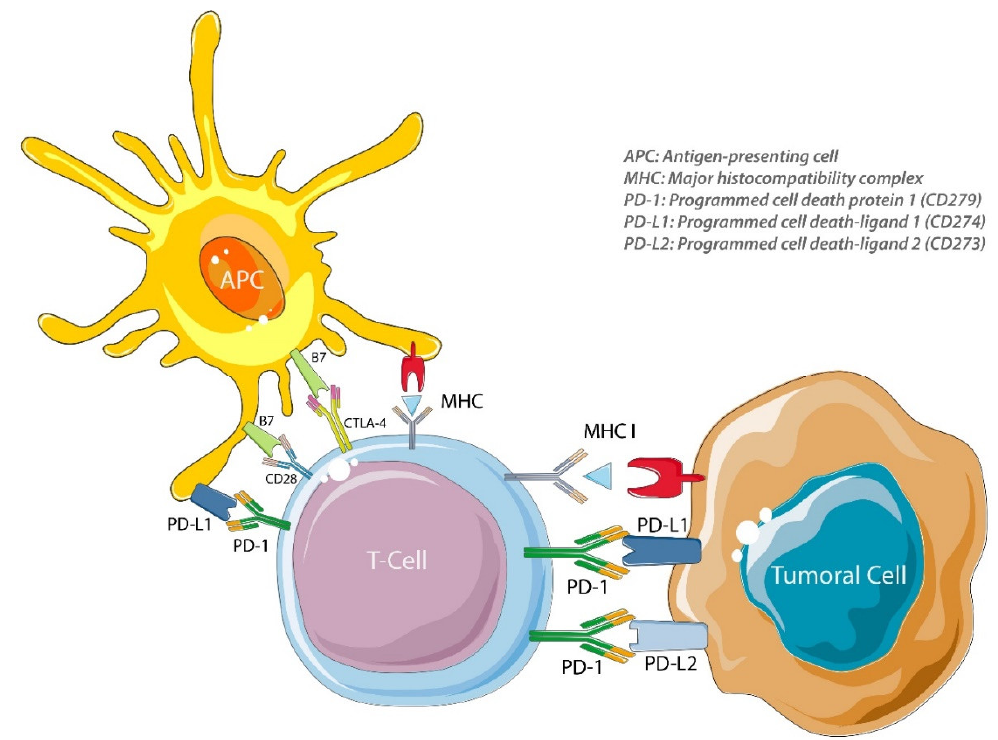
Figure 1. PD-1, PD-L1 and CTLA-4 targets of immune checkpoint inhibitors. APC = antigen-presenting cell, CD28 = cluster of differentiation 28, CTLA-4 = cytotoxic T lymphocyte antigen 4, MHC = major histocompatibility complex, MHC I = major histocompatibility complex class I, PD-1 = programmed cell death protein 1, PD-L1 = programmed cell death 1 ligand 1 and PD-L2 = programmed cell death